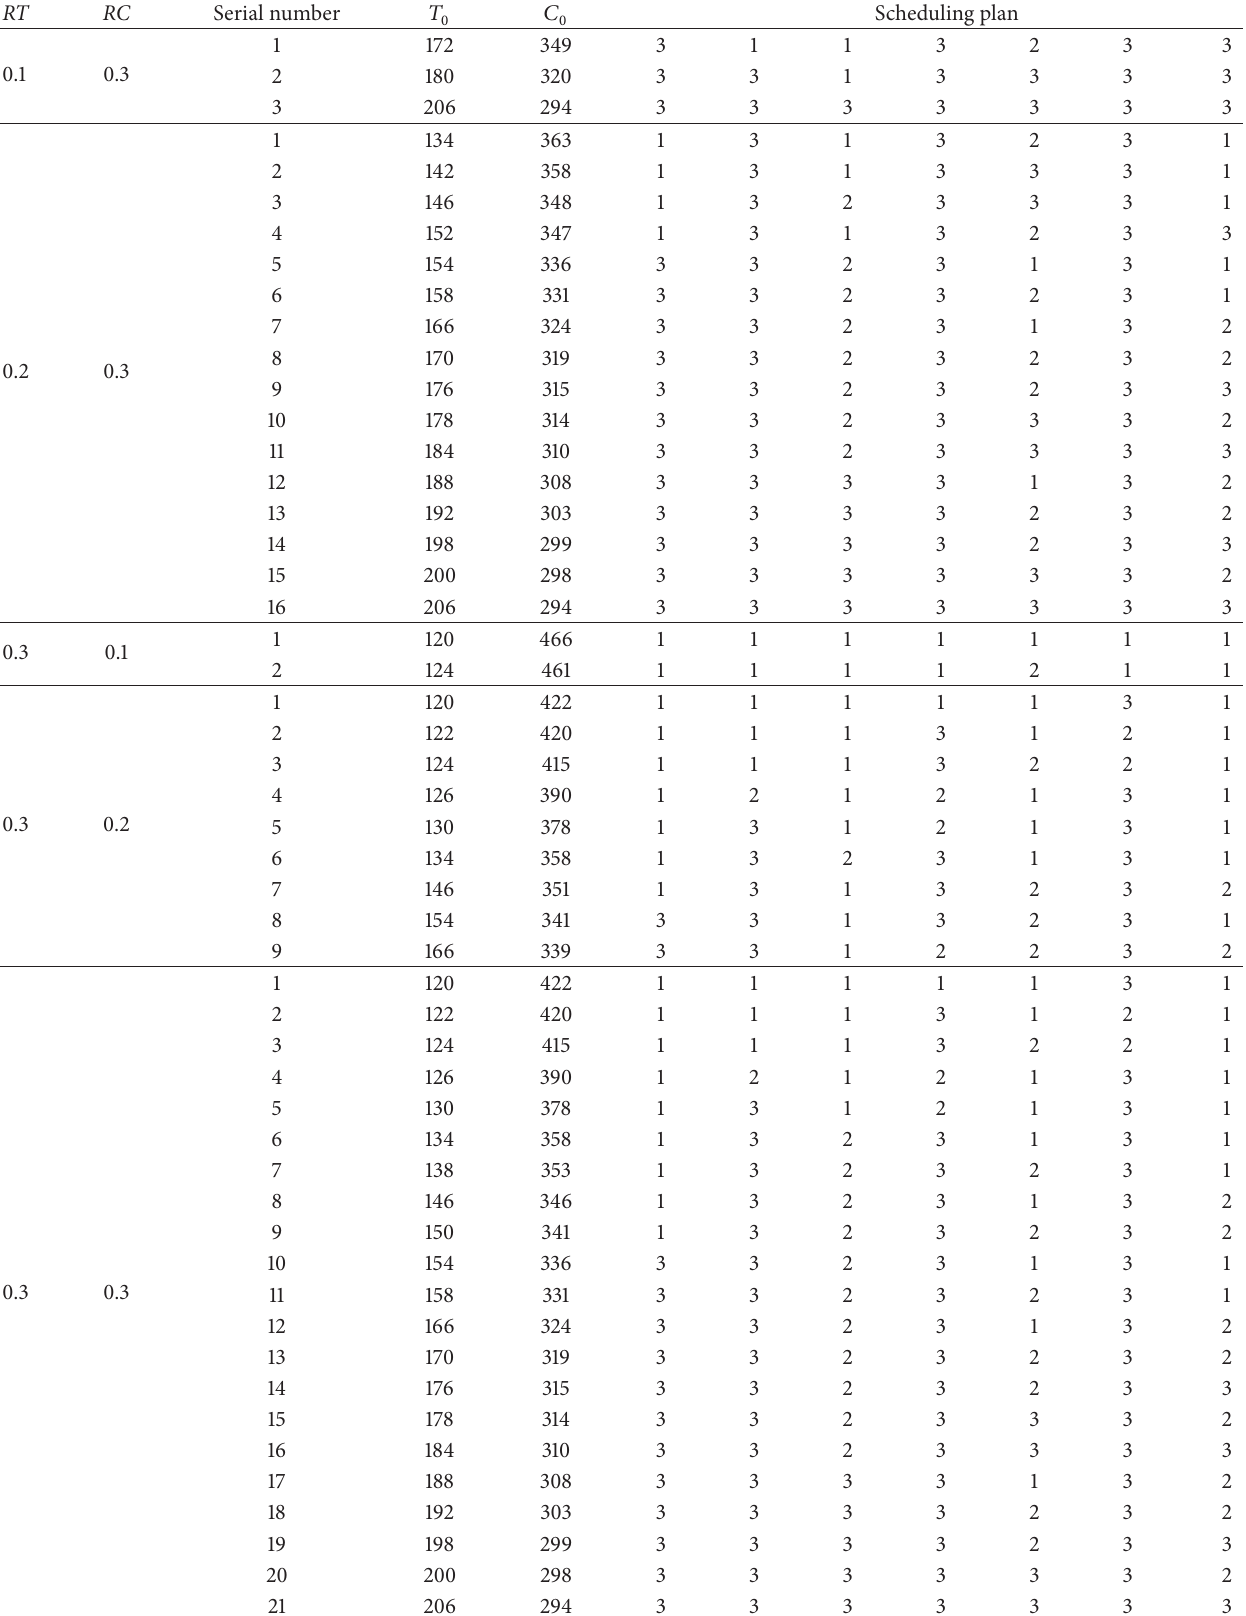
Table 2: Pareto solution under different RT and RC